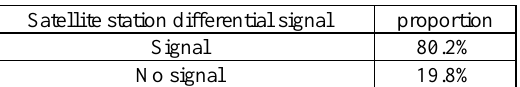
Table 7. Satellite station differential signal